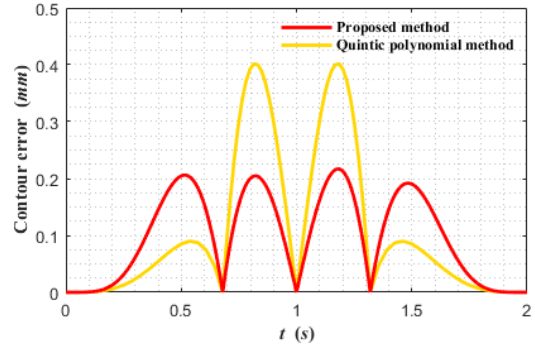
Figure 9. Contour